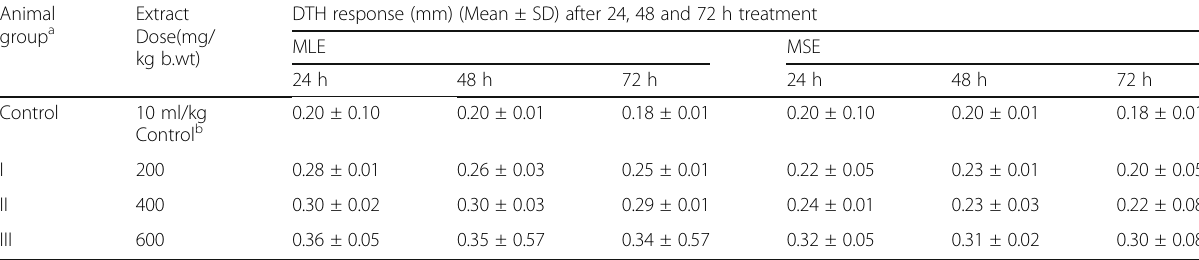
Table 7 Effect of methanolic leaf and stem extracts of B. lupulina on delayed type hypersensitivity response Animal Extract group a